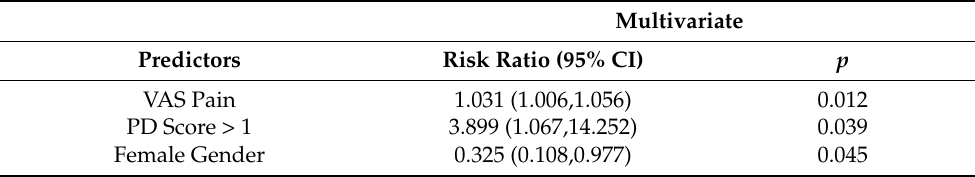
Table 3. Results of the multivariate Cox regression analyses. CI: confidence interval; VAS: visual analogue scale; PD: power